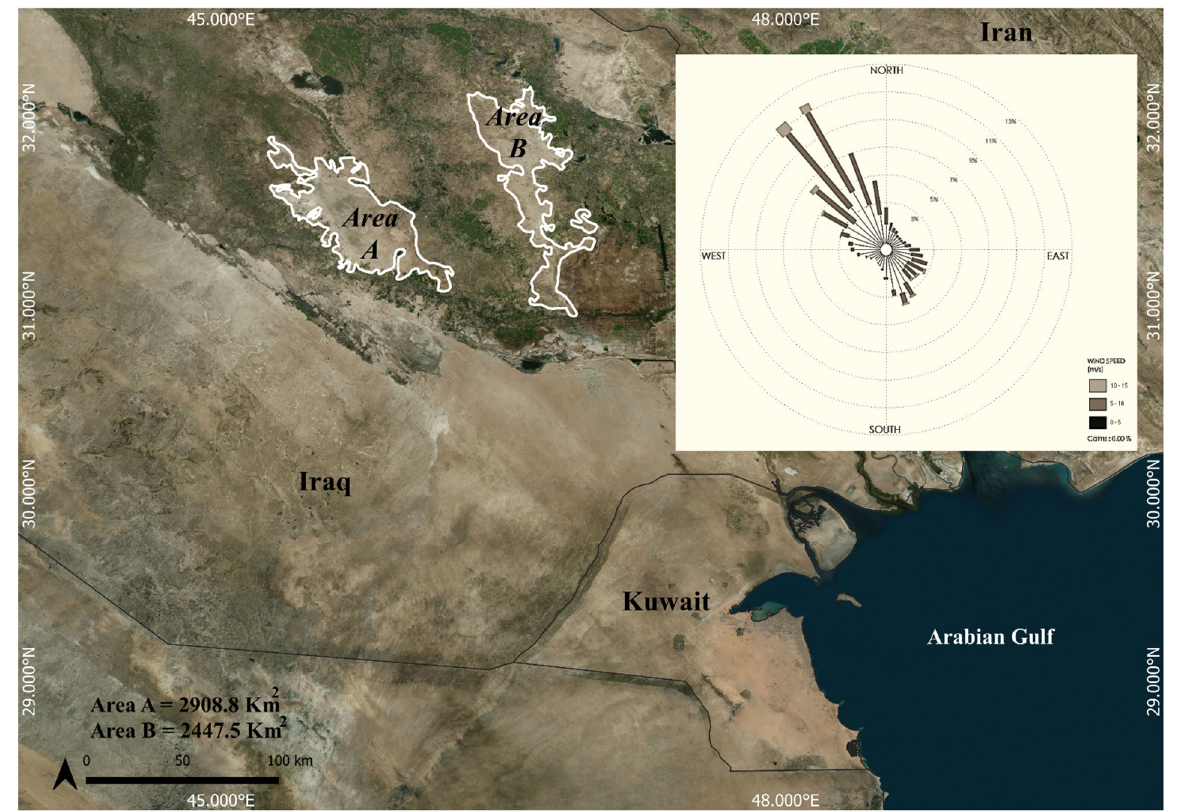
Figure 1. MODIS image of a typical SDS around Kuwait City. The SDS originated from the hotspots A and B shown in the image. The top right corner shows the mean wind rose for Kuwait City (2000–2020).